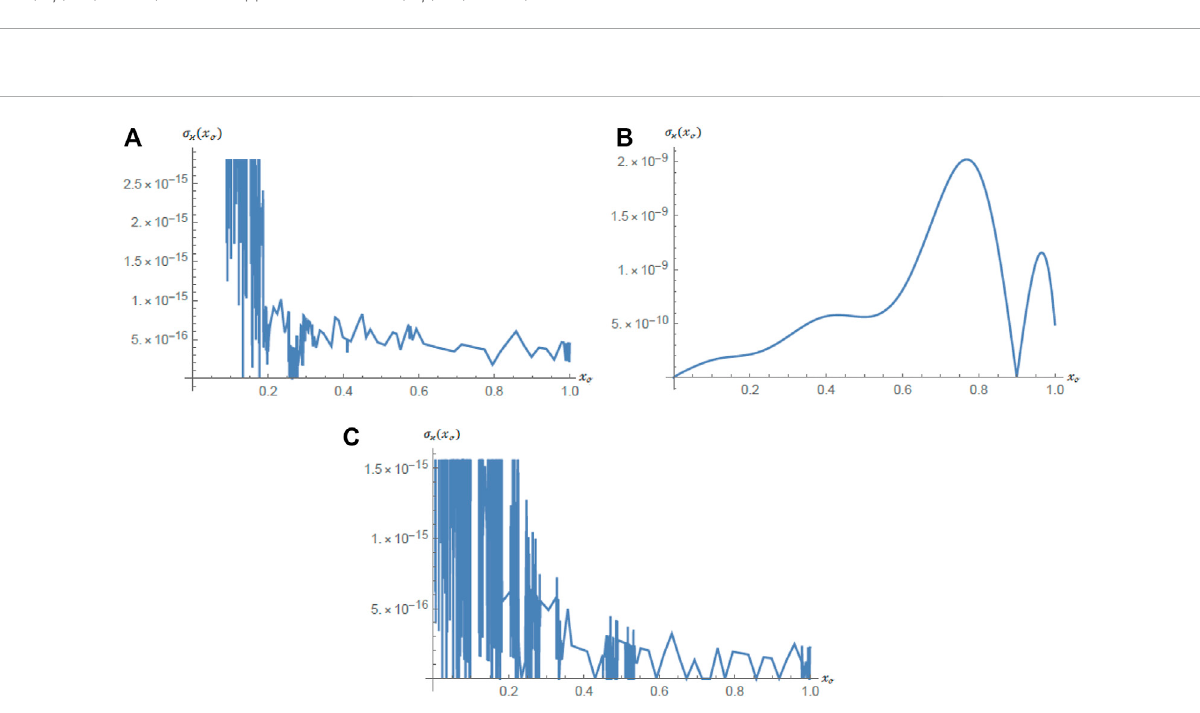
FIGURE 3 2- D Cartesian plots of RKHA relative errors of the FLM platform over Ξ : (A) application 1, when ( α , β ) (cid:2) ( 1/2 , 4/5 ) ; (B) application 2, when ( α , β ) (cid:2) ( 1/3 , 3/4 ) ; and (C) application 3, when ( α , β ) (cid:2) ( 1/4 , 4/5 )